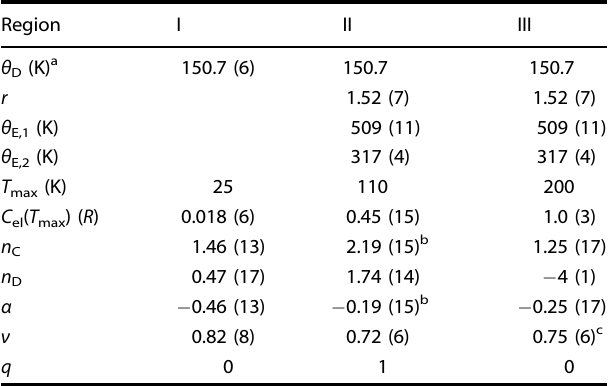
Table 1. Summary of the properties of the three QSL regions obtained in this study.